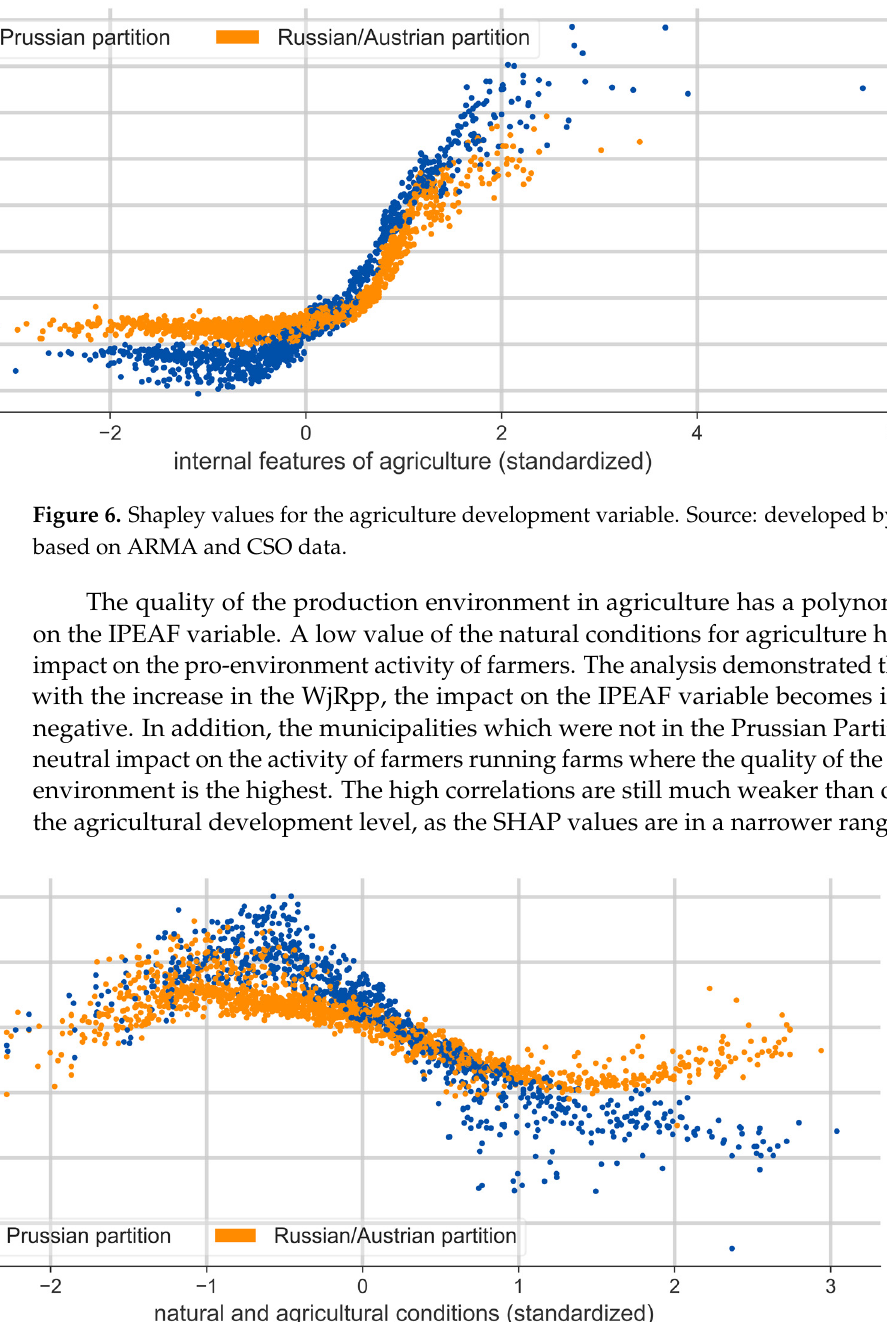
Figure 5. Values of SHAP parameter for particular determinants. Source: developed by the au- thors, based on ARMA and CSO data.